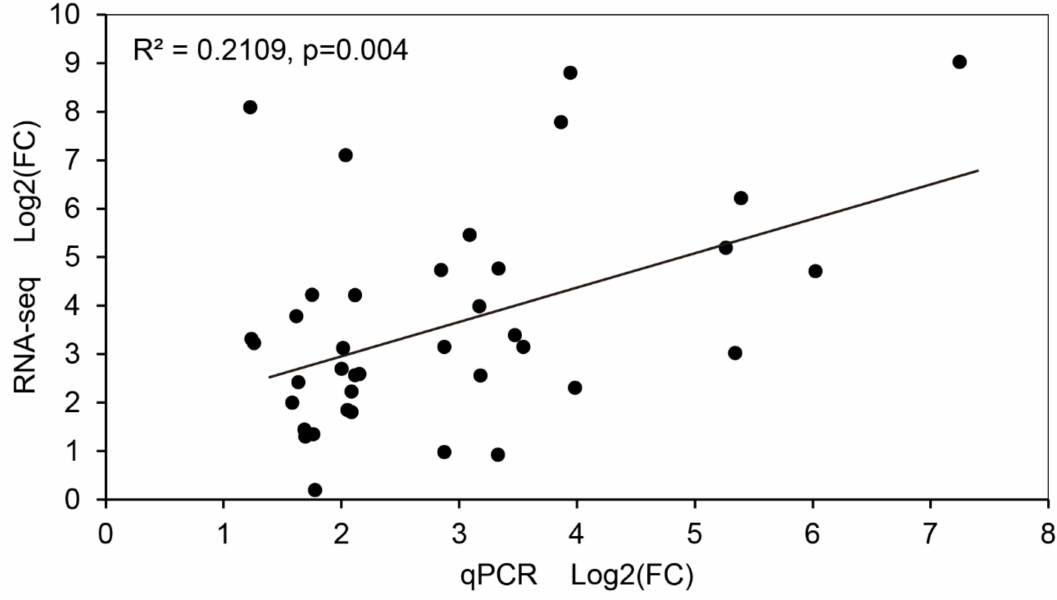
Figure 4. Correlation analysis of the gene expression fold change (FC) calculated from the quantitative real-time (qRT)-PCR and RNA-seq data. Pearson’s correlation (two tailed) was used for estimating p-values and r (n = 38) in SPSS